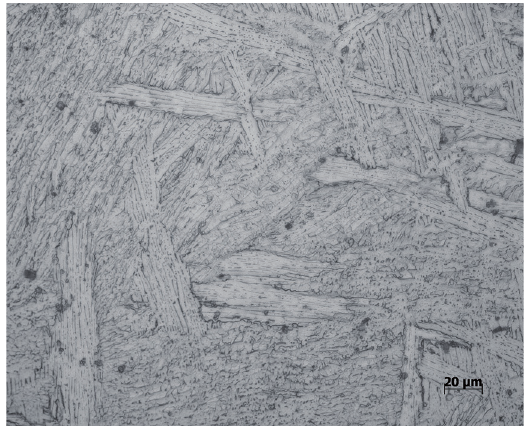
Figure 1: Microstructure of Ti-6Al-4V-0.1Ru titanium alloy after hot